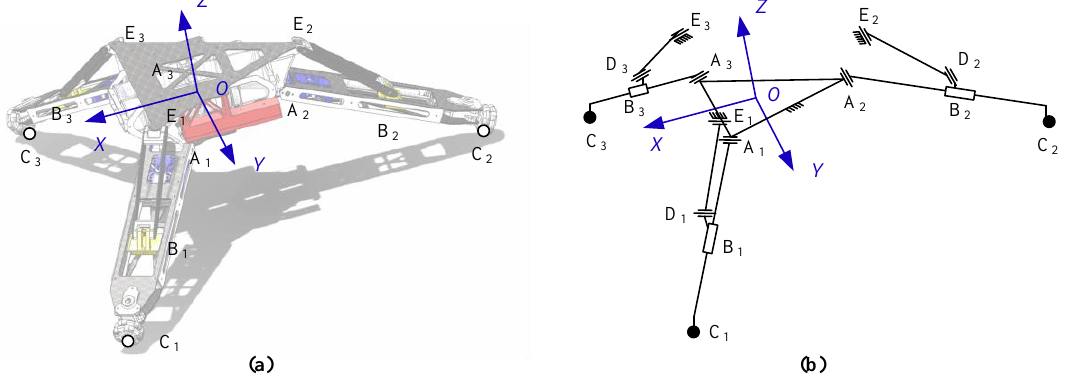
Figure 6. ( a ) The structural and ( b ) kinematic diagram of the landing gear robot.